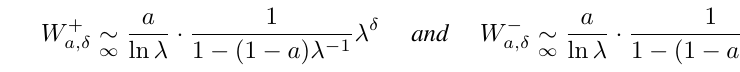
with a = 3 and n = 14 a,δ 7